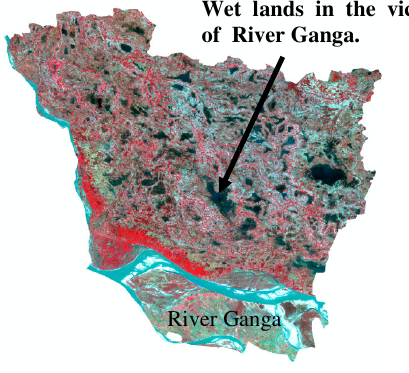
Fig. 5 Fals e color composite of IRS LISS IV Vaishali distrit Collateral data analysis : Temperature (Max & Min) and humidity data, Kala azar disease incidence, cropping pattern, chemical analysis of soil data and Man (MHD) from most of the villages collected and analysed. The analysis dynamics indicate periodicity at seasonal and inter